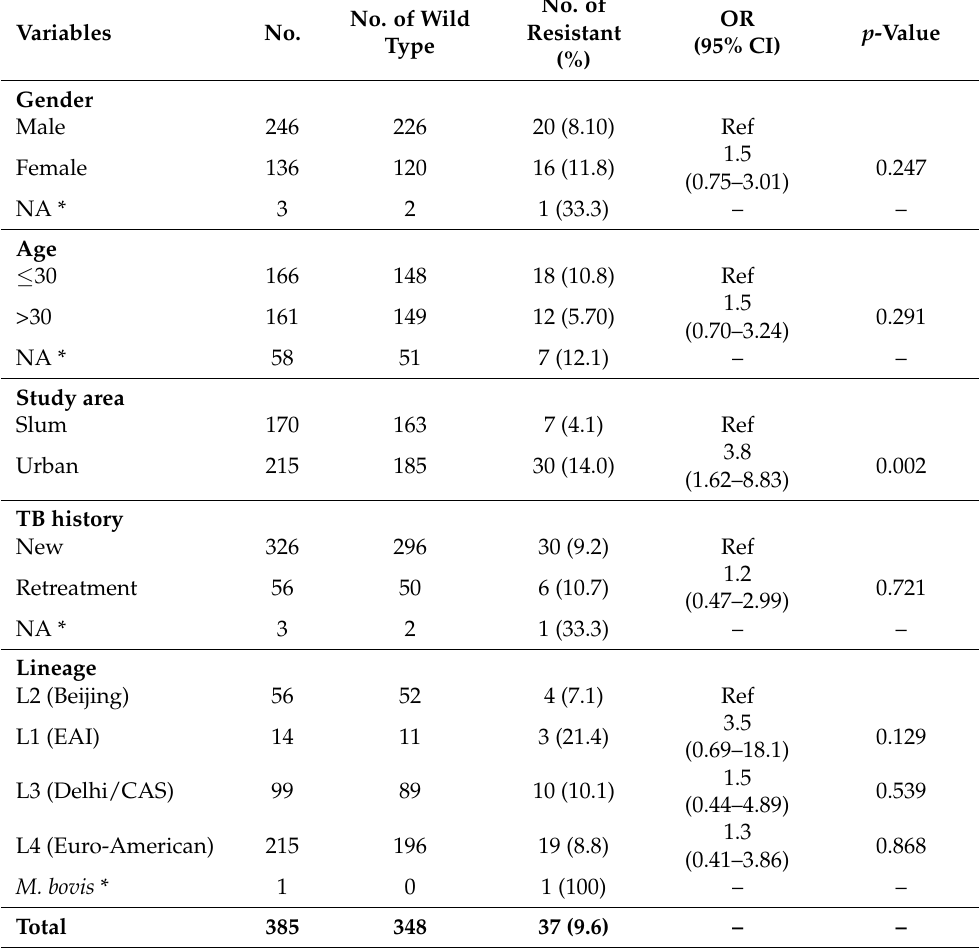
No. of OR No. of Wild p -Value Resistant (95% CI) Type (%)